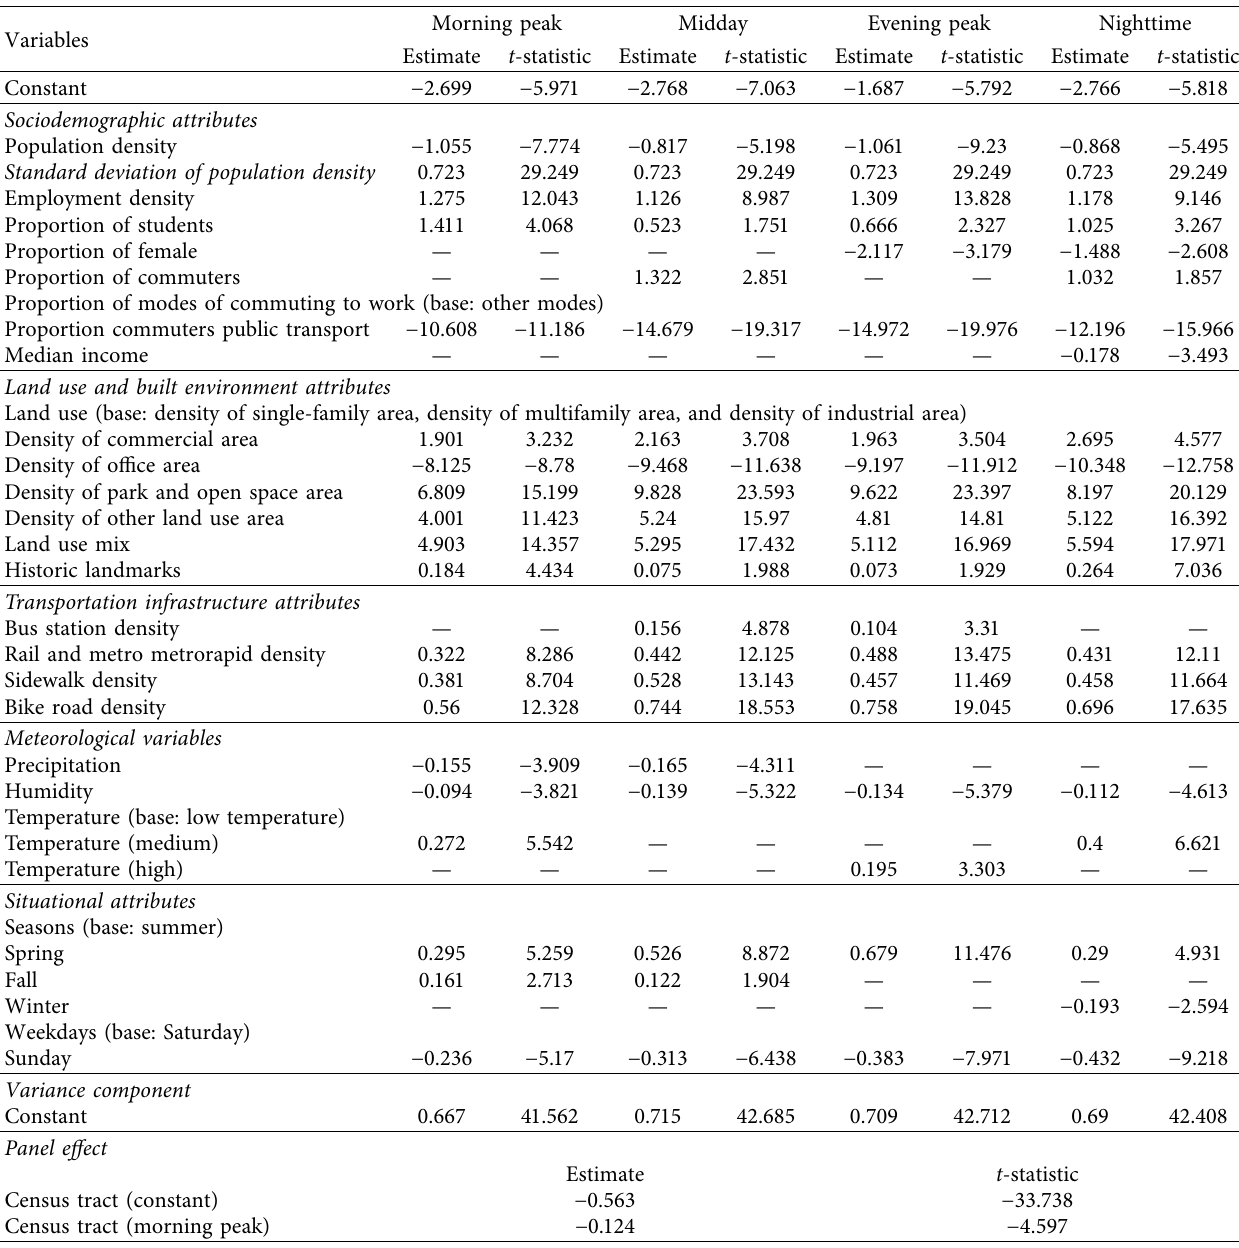
Table 3: Panel linear regression model results for